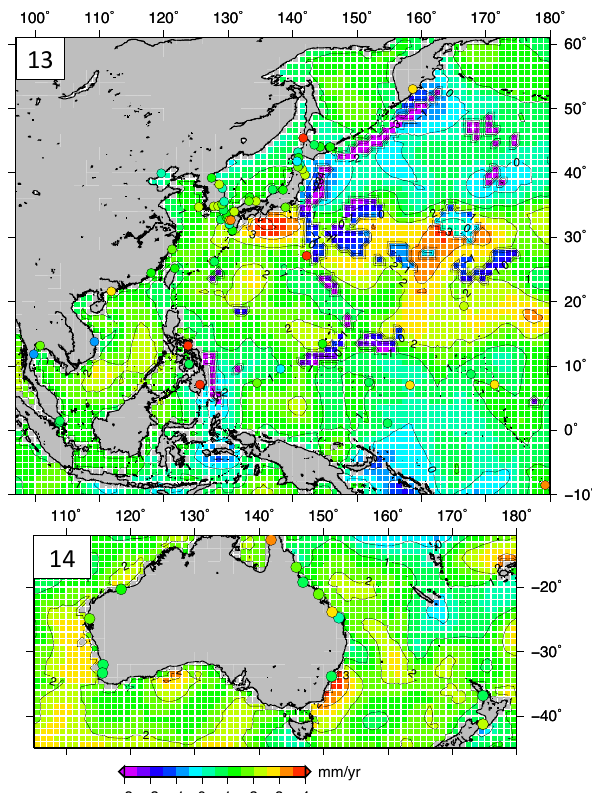
Figure 8. Trends in sea-level change (mmyr − 1 ) over the period 1961–2003, for regions (13) Asian Pacific and (14) South Pacific West. Zoom of Fig. 4. Regions indicated in Fig. 1.